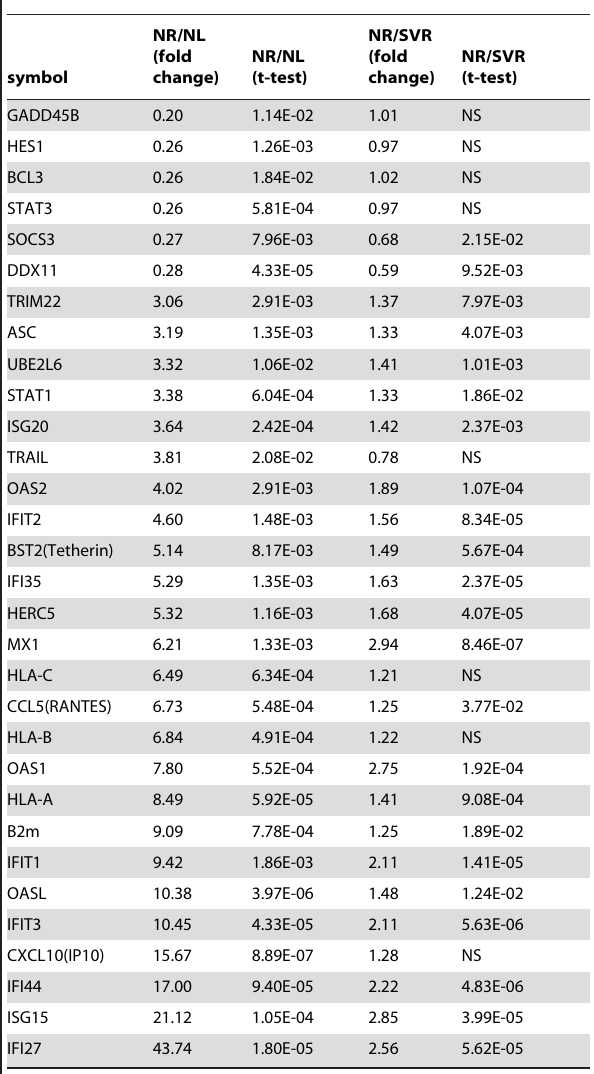
Table 3. List of genes that had significantly different expression levels in NR and NL (fold change , 1/3, 3 , , and p ,